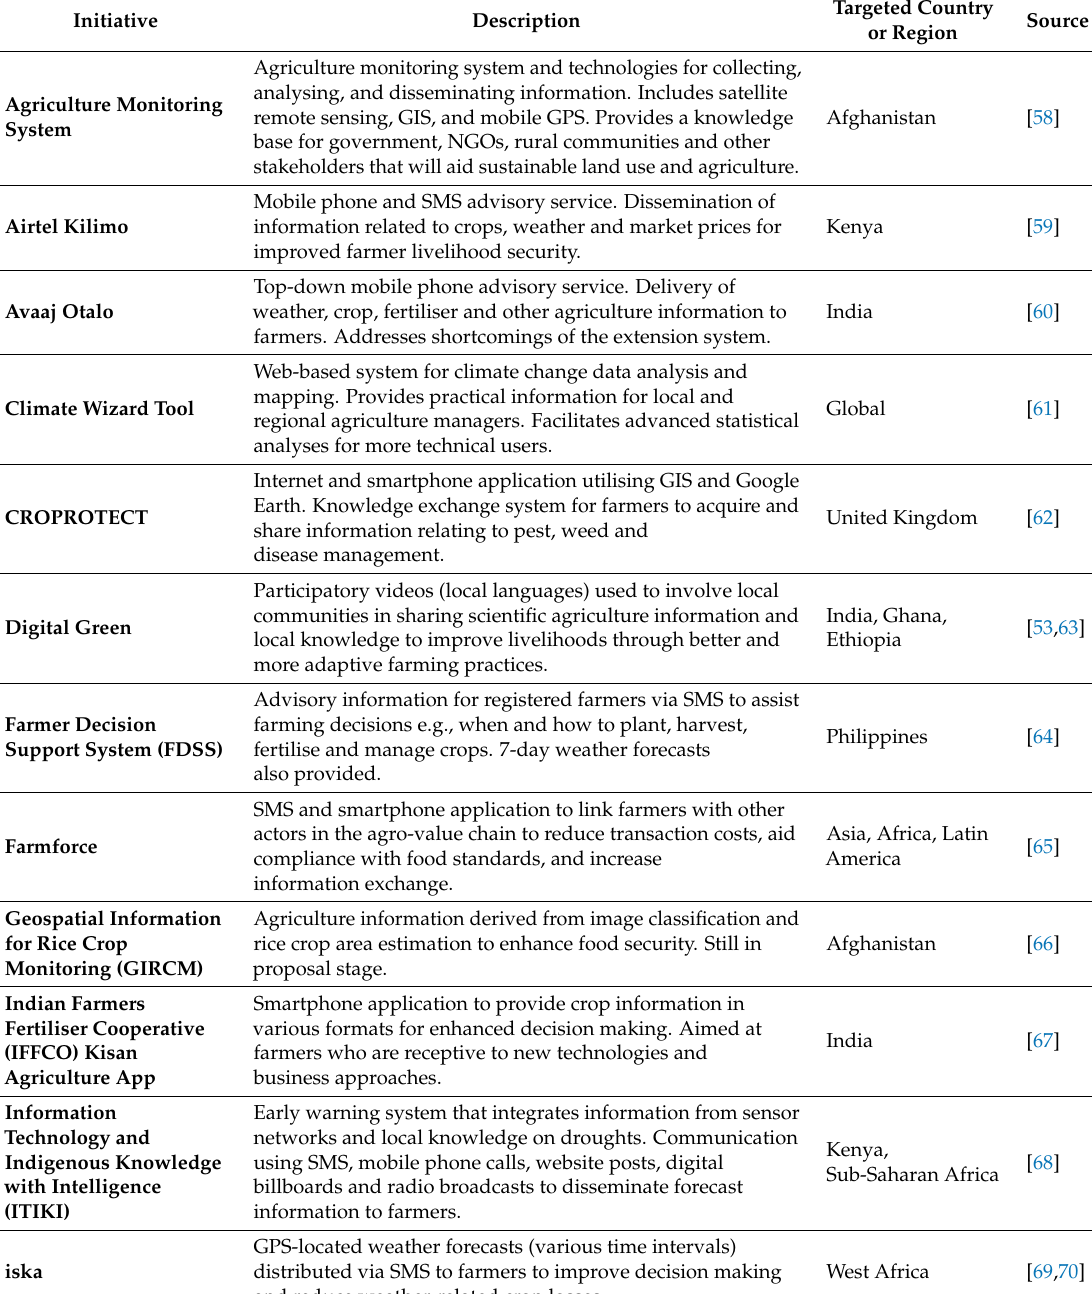
Table 1. All AGI initiatives identified for this review, including description, target locations and source. Initiative